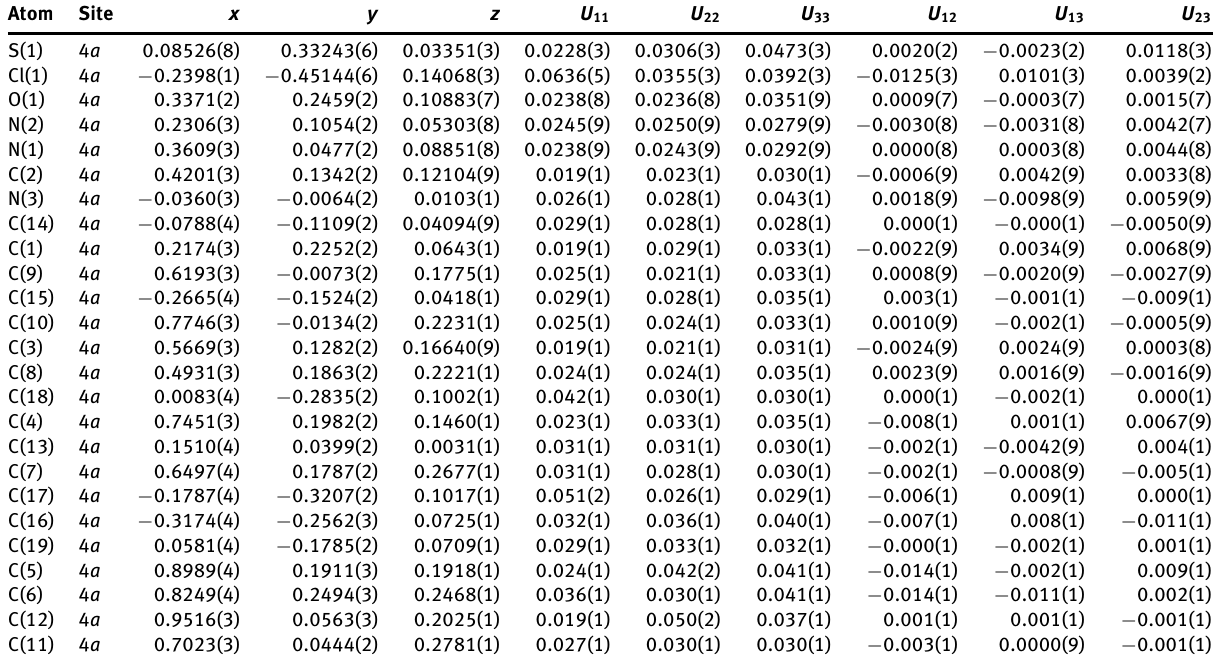
Table 3: Atomic displacement parameters (Å 2